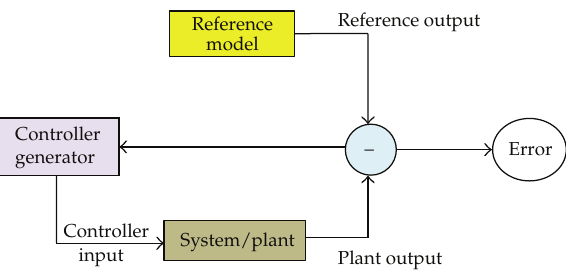
Figure 2: Block diagram of controller